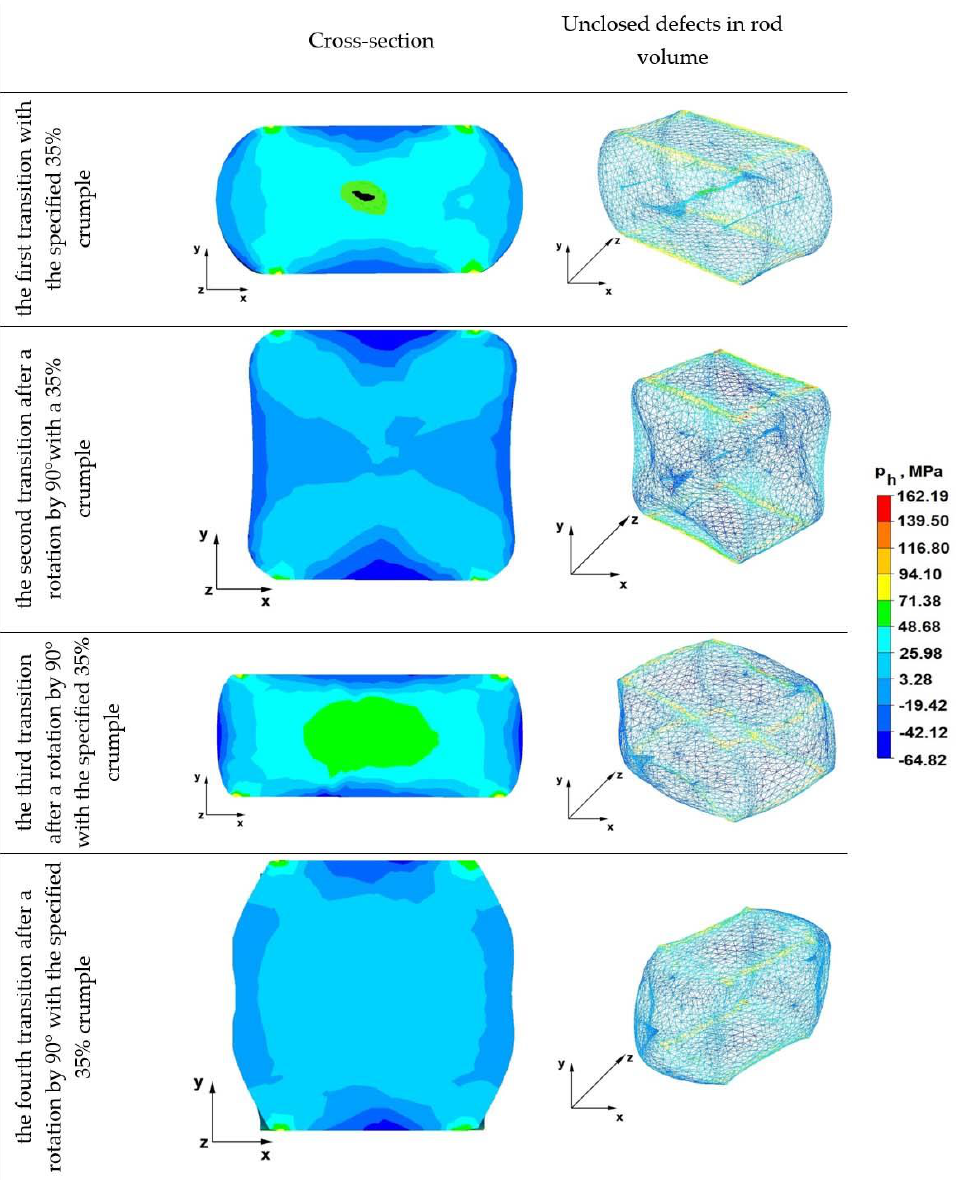
Figure 10. Hydrostatic pressure distribution in rod elongation operations in flat anvils. From the analysis of the data of the first transition shown in Figure 10, it follows that the axial discontinuity and the two external discontinuities located on the right and left sides of the forged rod were not welded. Where axial discontinuity occurred, the hydrostatic pressure value was 49 MPa, while where other discontinuities occurred, the pressure value was in the range of 15–26 MPa. The discontinuities in the right and left area of the forged rod did not become welded, because the metal floated freely along the x-axis without being limited by the side surfaces of the shaped anvils, as was the case with forging in anvils, e.g., rhombic flat anvils. On the other hand, all discontinuities in the areas of the lower and upper forged rods under the direct action of flat anvils were welded, because there was a favorable distribution of compressive stresses, directed along the y-axis in the direction of the rod axis. From the data of the distribution of hydrostatic pressure values during the elongation operation in flat anvils, it appears that after the second forging transition, there was still no complete welding of discontinuities remaining after the first transition. It is